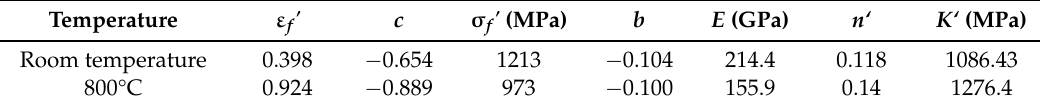
Table 5. The transition of fatigue life of Alloy 617 Weldments at room temperature and 800 °C. Temperature 2N Room temperature